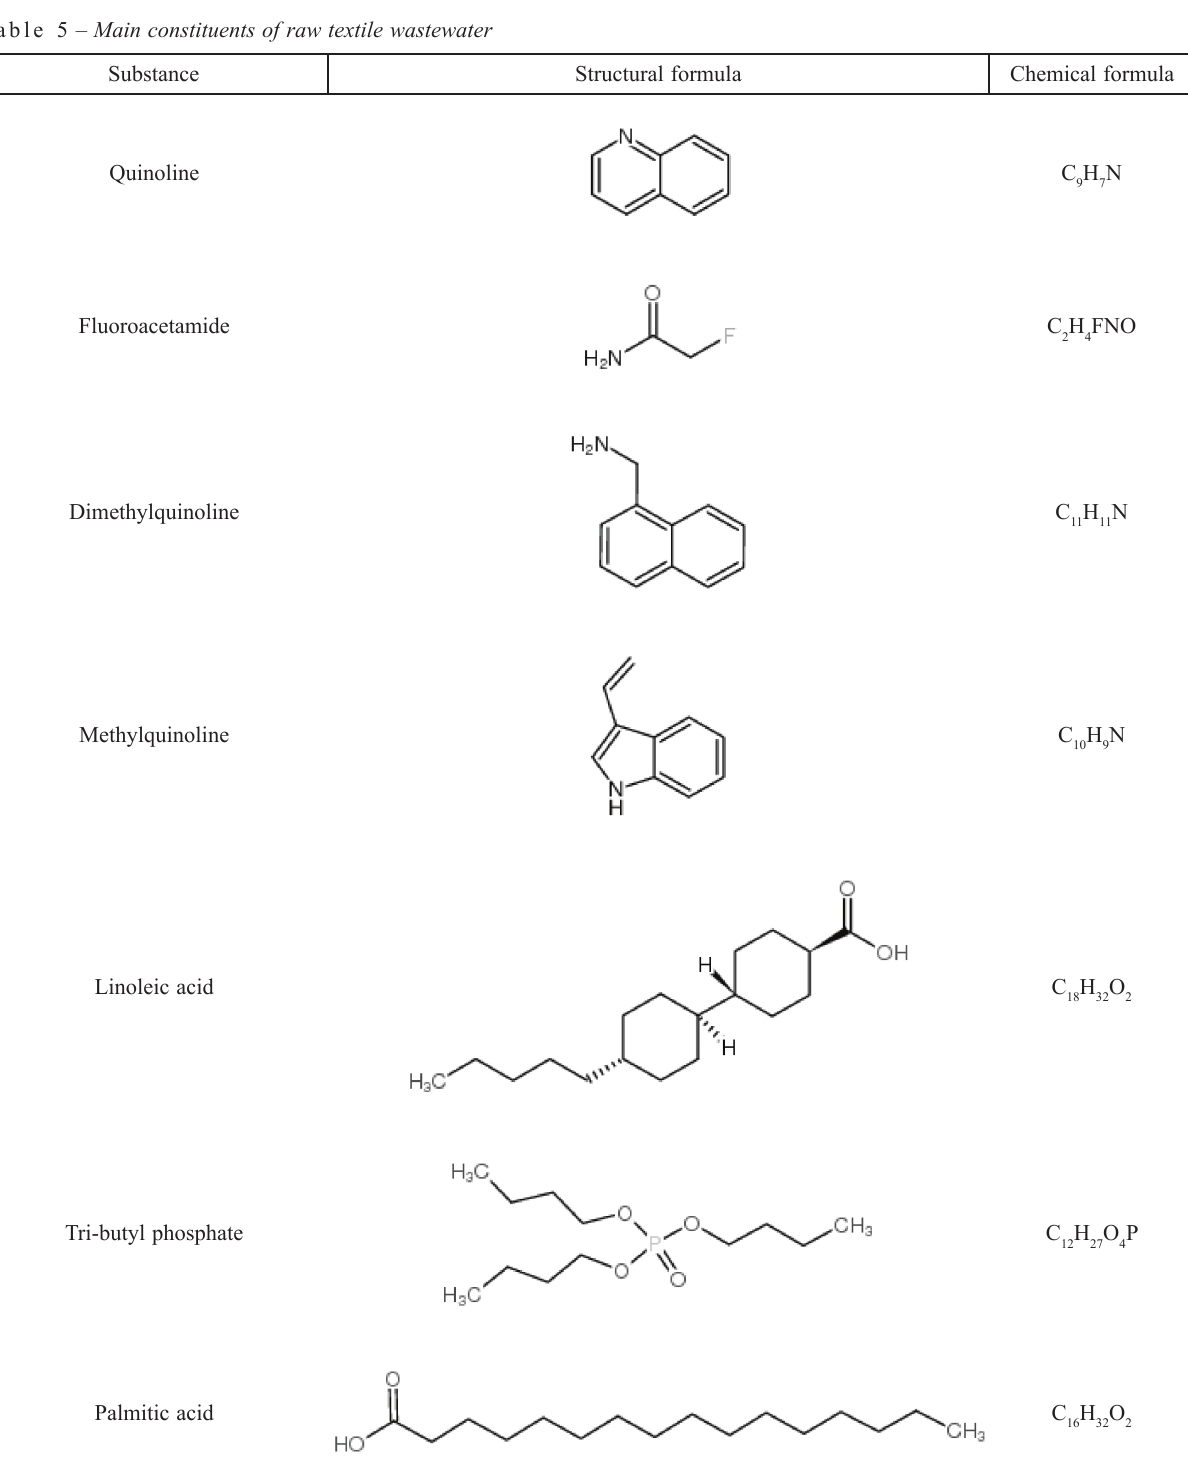
/AC nano-photocatalytic degradation 2